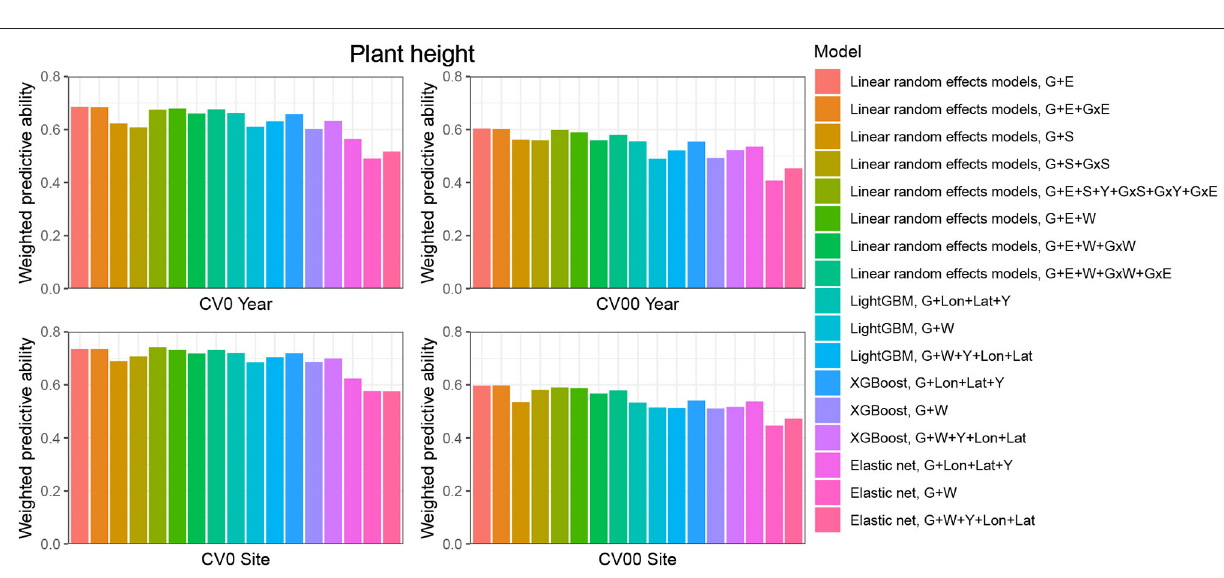
FIGURE 4 | Weighted average predictive ability across 71 environments obtained for four cross-validation schemes and 16 models for the trait plant height. G, main effect of SNPs markers (genomic relationship matrix for LRE models; principal components derived from marker matrix for machine learning-based approaches); Y, year effect; S, site effect; GxS, genotype-by-site interaction; E, environment effect; GxY, genotype-by-year interaction; GxS, genotype-by-site interaction; GxE, genotype-by-environment interaction; GxW, interaction between W and SNPs; Lon, longitude; Lat, latitude; W, effect of weather- and soil-based covariates. For linear random effects models, results with models including longitude and latitude data in the matrix W are depicted